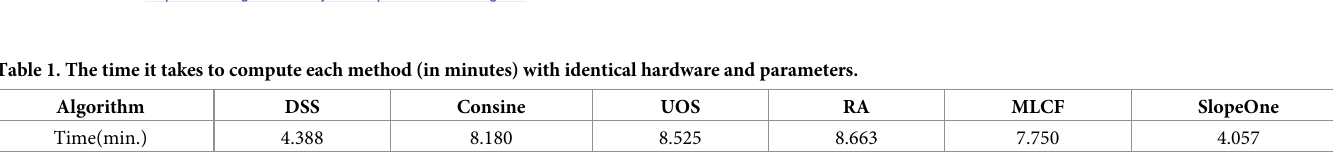
Fig 13. The actual number of neighbors used in prediction (y-axis) against the number of neighbors that algorithms plan to select (x-axis). The number of users selected for the experiment is 1000.